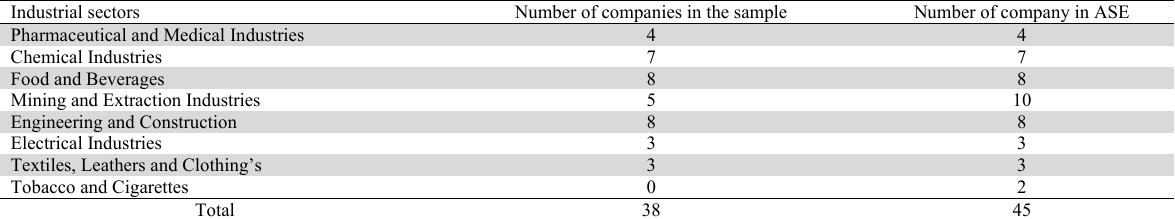
number of companies in the sample classified within industrial sectors Industrial